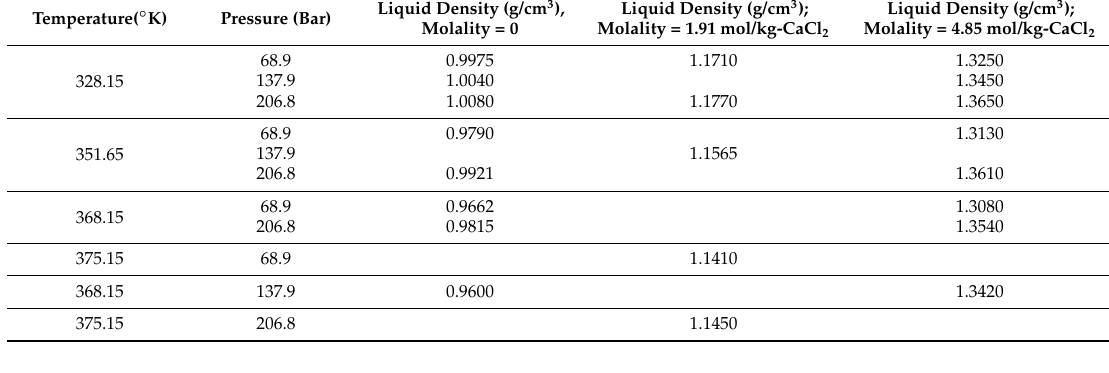
Table 2. Results from measurement of density of pure H 2 O saturated with CO 2 in P-T conditions of